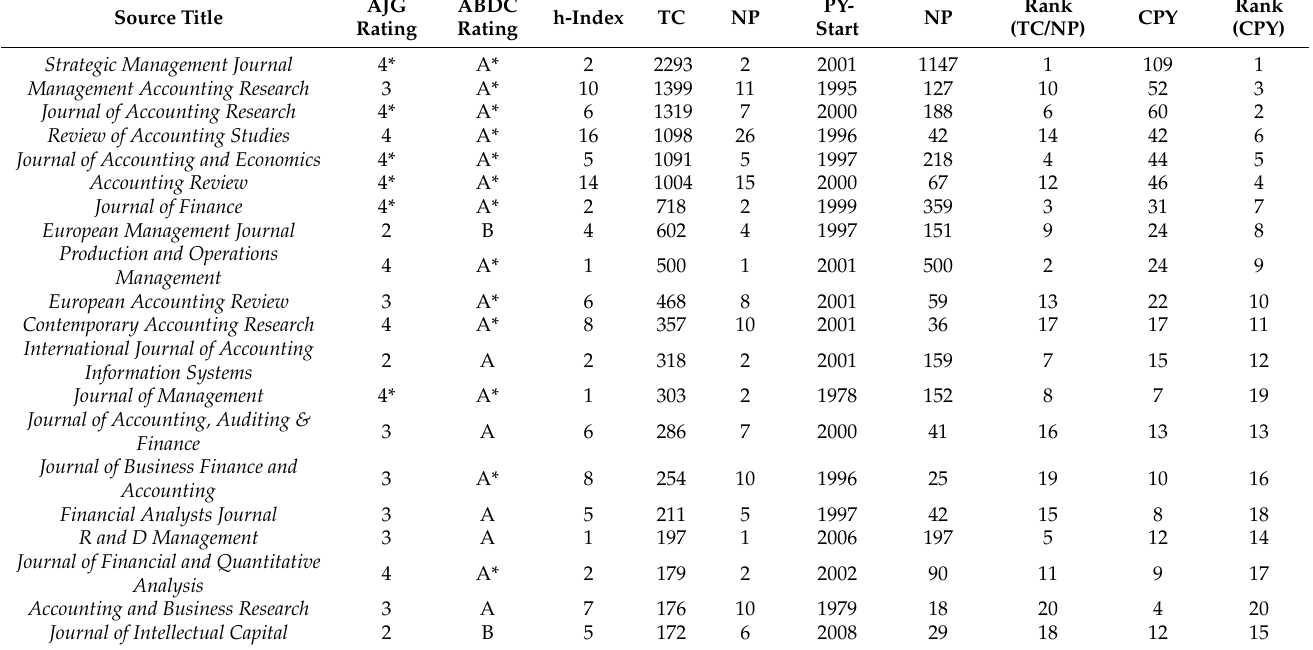
Table 1. Leading Performing Publishing Outlets in the EVA Research